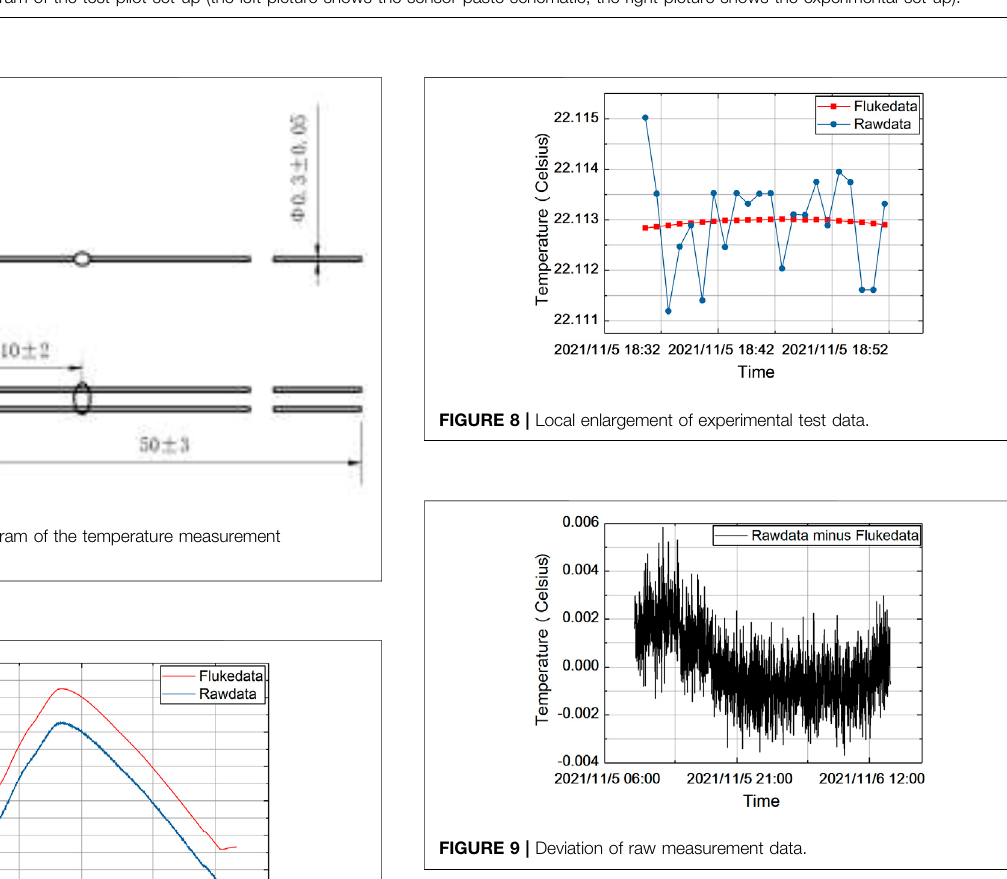
FIGURE 5 | Schematic diagram of the test pilot set-up (the left picture shows the sensor paste schematic, the right picture shows the experimental set-up).